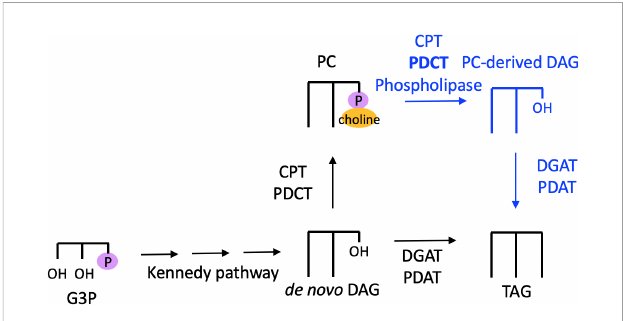
FIGURE 5 PC-derived DAG pathway to TAG synthesis. Black text and arrows represent the de novo synthesis pathway to PC and TAG, blue text and arrows represent the PC-derived DAG pathway to produce TAG. The enzyme PDCT is shown in bold because it is believed to catalyze the major PC-DAG conversion. CPT, cytidine-5 ′ -diphosphocholine: diacylglycerol cholinephosphotransferase; DAG, diacylglycerol; DGAT, diacylglycerol acyltransferase; G3P, glycerol 3-phosphate; PC, phosphatidylcholine; PDAT, phospholipid:diacylglycerol acyltransferase; PDCT, phosphatidylcholine:diacylglycerol cholinephosphotransferase; TAG, triacylglycerol.